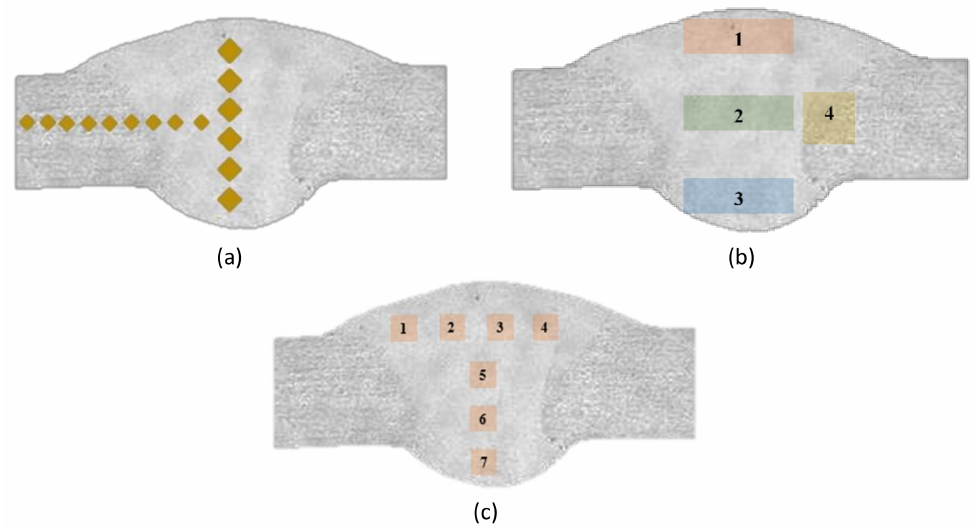
Figure 3. Schematic illustration of ( a ) microhardness test ( b ) location of microstructure and ( c ) location of energy dispersive spectometer (EDS)